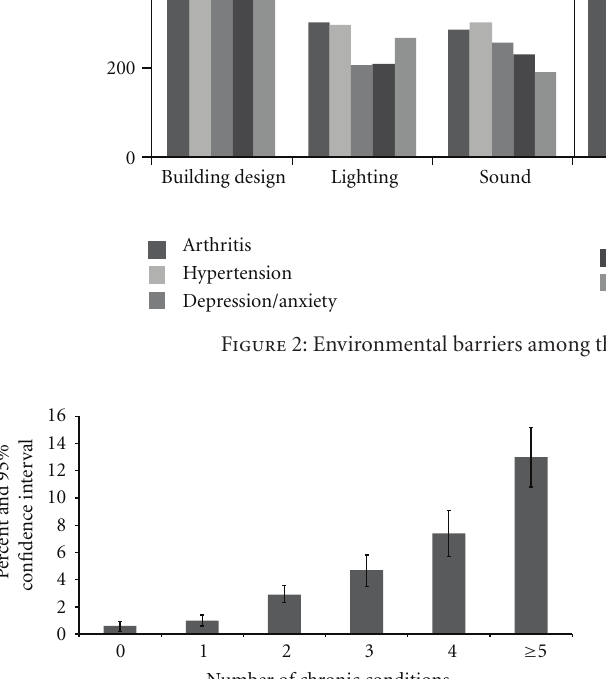
Figure 3: Prevalence of community participation restriction, by number of chronic conditions,